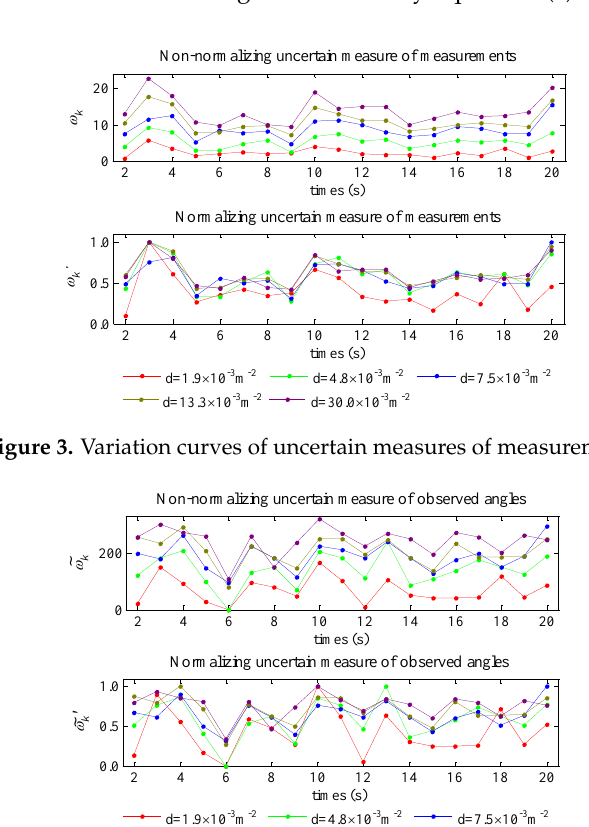
Figure 3. Variation curves of uncertain measures of measurements.